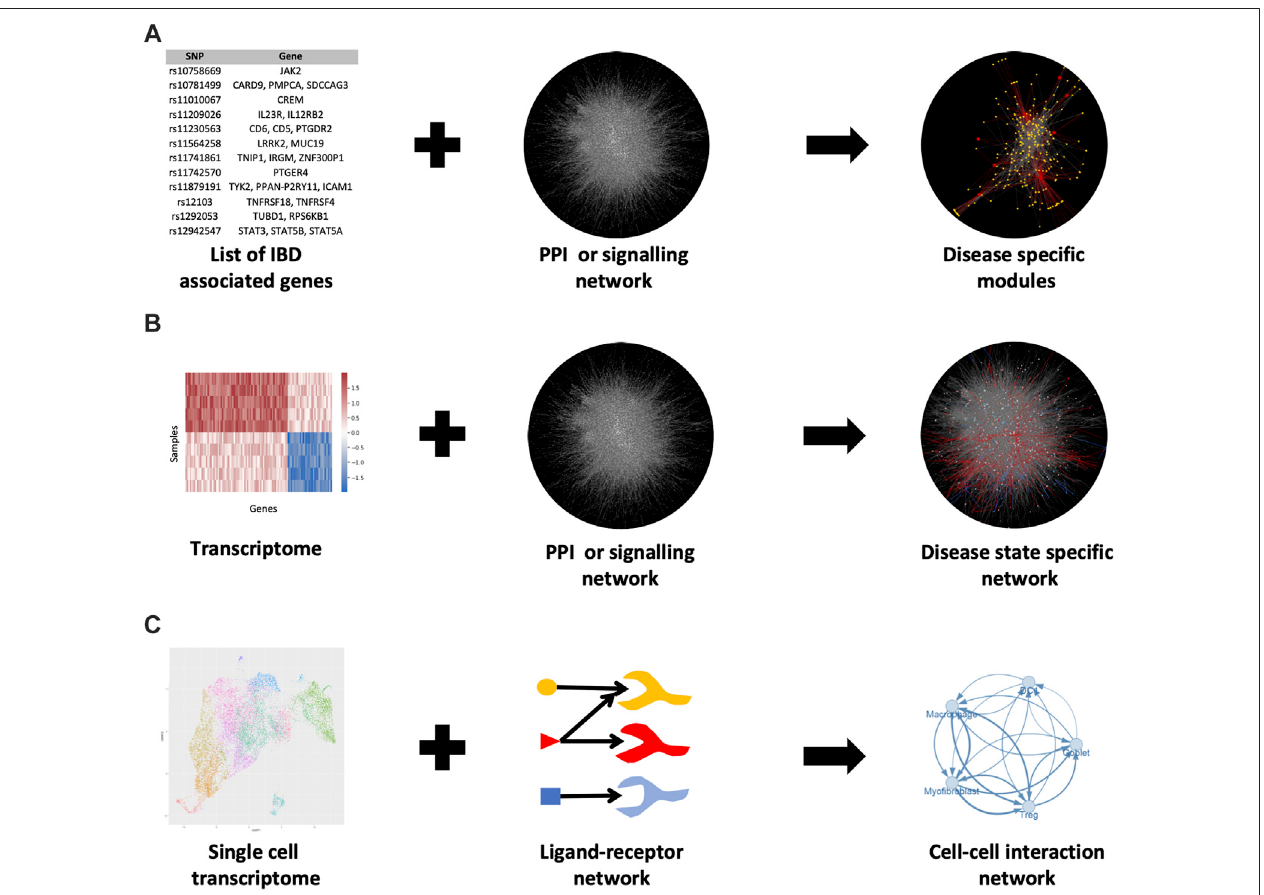
FIGURE 2 | Various methods for generating PPI networks in IBD. (A) Known IBD-associated genes can be mapped to a PPI network and the nearby genes in the networkcan be associated withIBDas well(guilt by association) (B) Mapping atranscriptometothe PPInetwork canelucidate disease-speci fi cmodules inthe network (C) Single-cellRNA-seqdatacombinedwithintercellular(ligand-receptor)communicationnetworkscanshowhowvariouscellsareinteractingwitheachotherindisease or healthy states. For b) the data from (Olsen et al., 2009) was used. For c) the uniform manifold approximation and projection (UMAP) plot (a nonlinear dimensionality reduction technique for visualising high-dimensional data) was generated using data from Lukassen et al., 2020 (Lukassen et al., 2020).